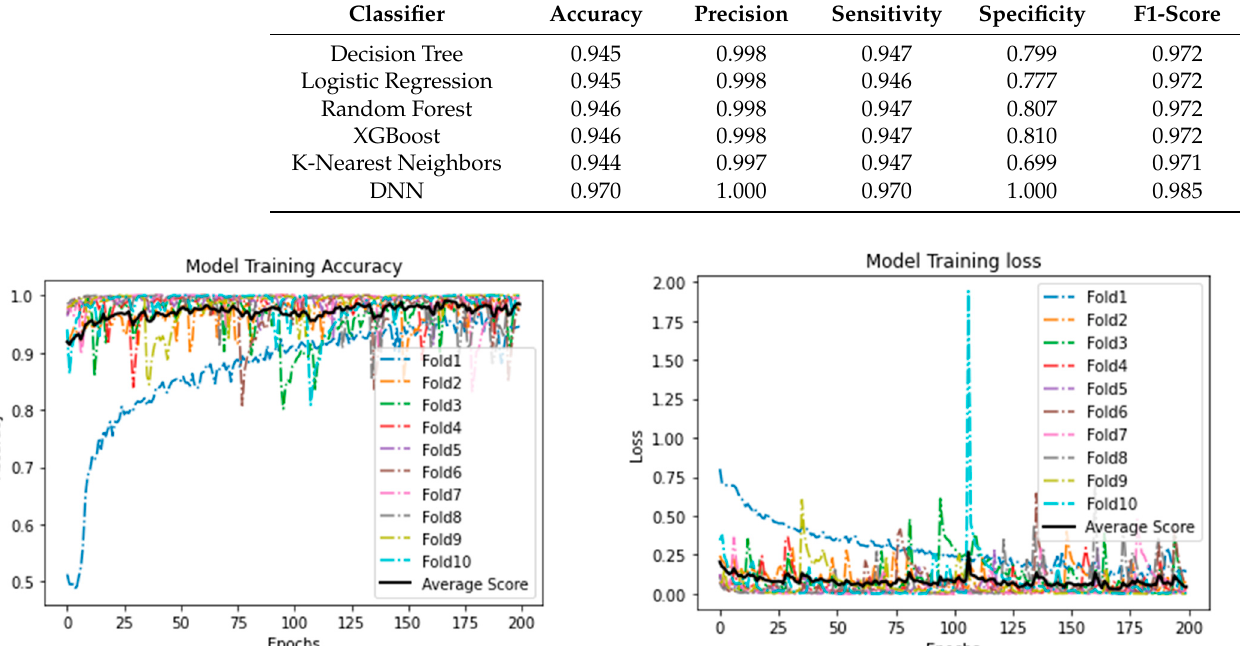
Figure 4. Proposed Deep Learning model: training accuracy and loss.